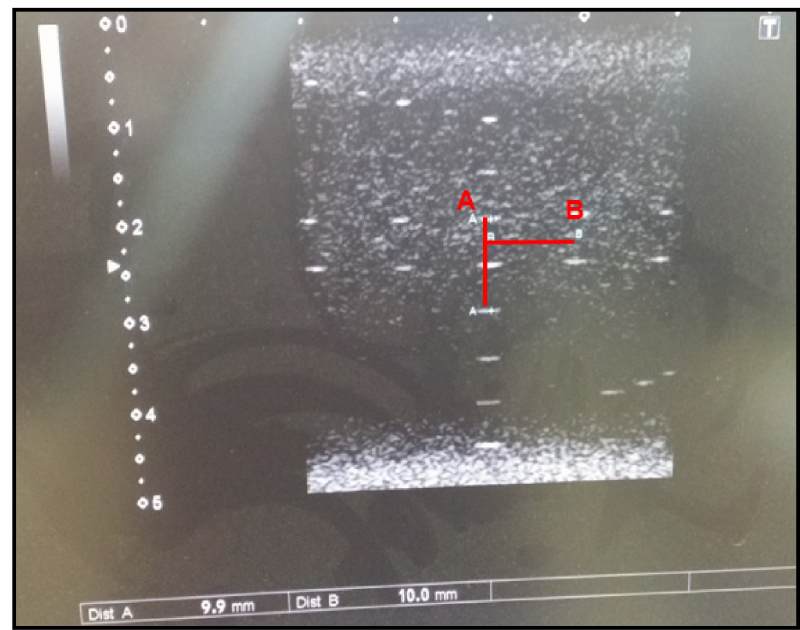
Figure 5. Distance accuracy.